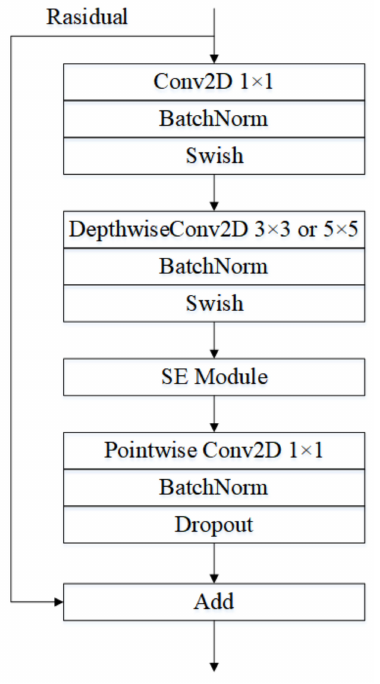
Figure 3. MBConv structure